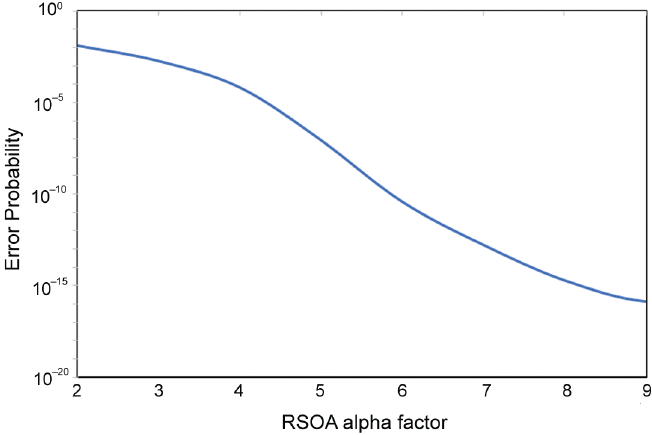
Figure 13. Error probability vs. RSOA alpha